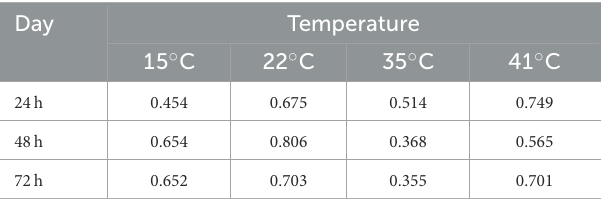
TABLE 2 Broad sense heritability (BSH, H 2 ) calcuated using the observed growth of the 89 A. fumigatus strains across the 3 days and four